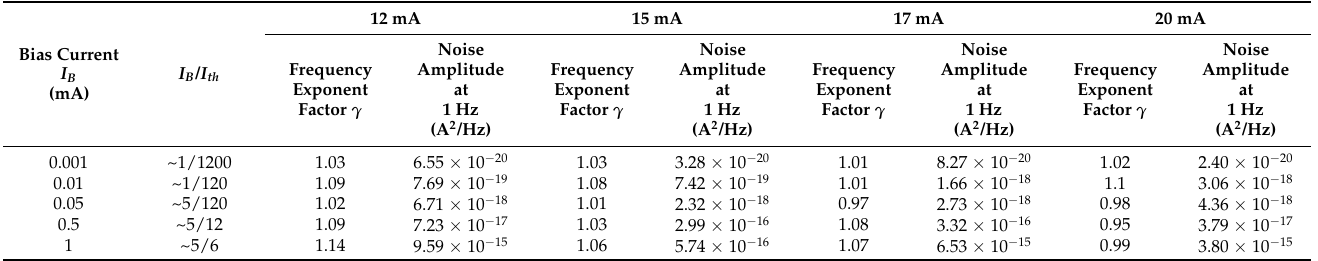
Table 1. The frequency exponential factor and noise amplitude at different forward bias currents.